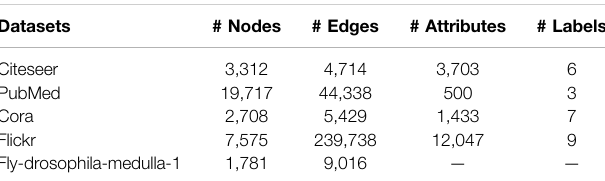
TABLE 1 | Dataset